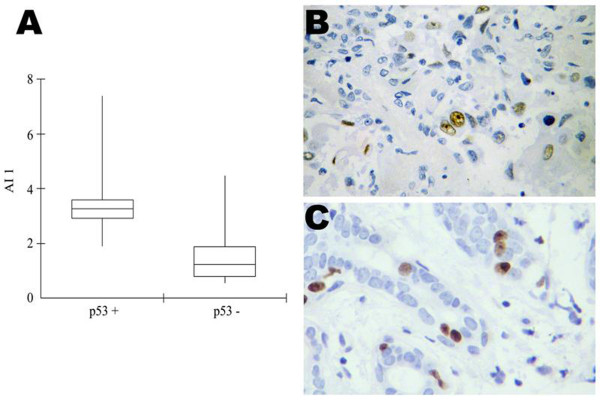
Parameters statistically associated with p53 positivity. (A) p53 immunopositivity was associated with a statistically significant higher anti-apoptotic index 1 (p = 0.004). (B) p53 immunostaining in a sample of pleomorphic adenoma (C) high proliferation index in a sample of polymorphous low grade adenocarcinoma. High proliferative activity was associated with p53 positivity. AI-1 = BCL-2/BAX (Original magnification 400×).